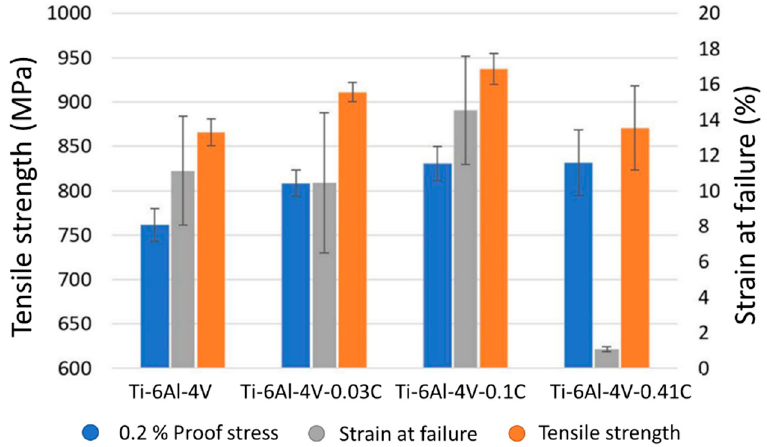
Figure 11. Effect of carbon additions on Ti-6Al-4V mechanical properties (adapted from [54]).